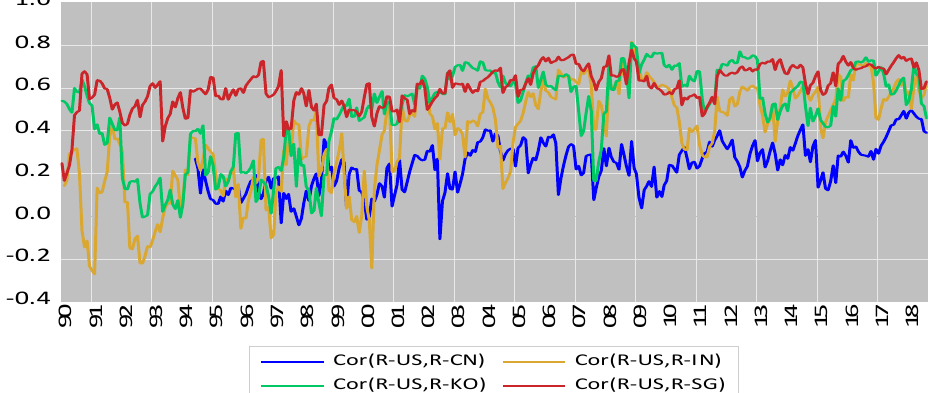
Figure 2. Plots of dynamic correlation coefficients for U.S. and major Asia markets.